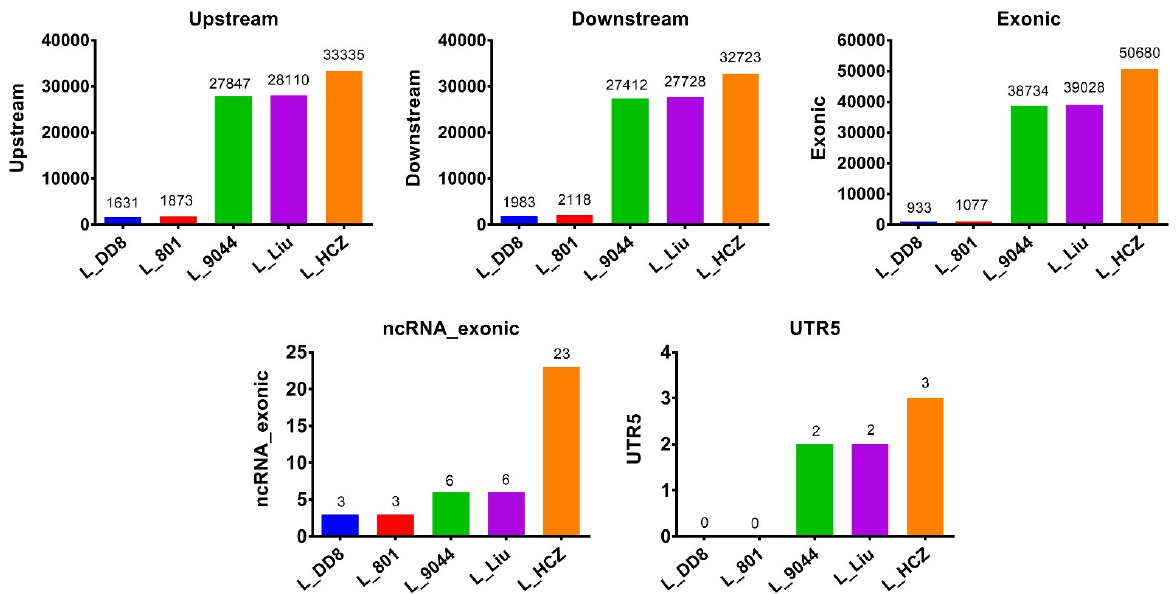
Figure 2. SNPs/InDels distributions. Upstream: variations located upstream of genes. Downstream: variations located downstream of genes. Exonic: variations located at the exonic region of genes.